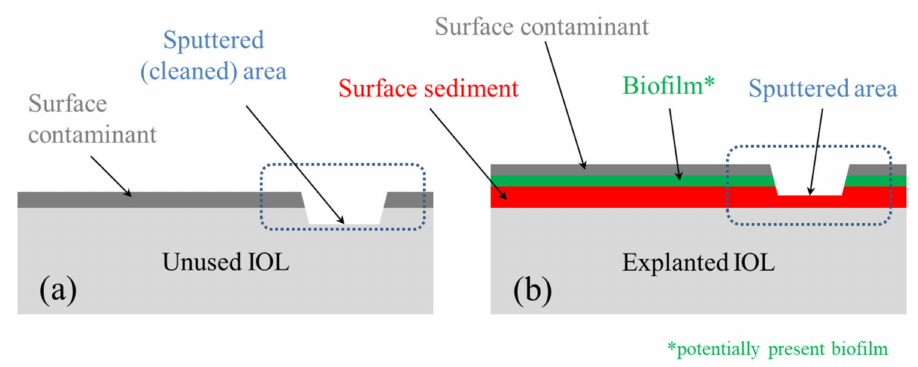
Figure 2. Schematic representation of cross section of characterized IOLs: ( a ) for the unused (reference) IOL and ( b ) for the explanted IOL. The diagrams are a section of the area marked in Figure